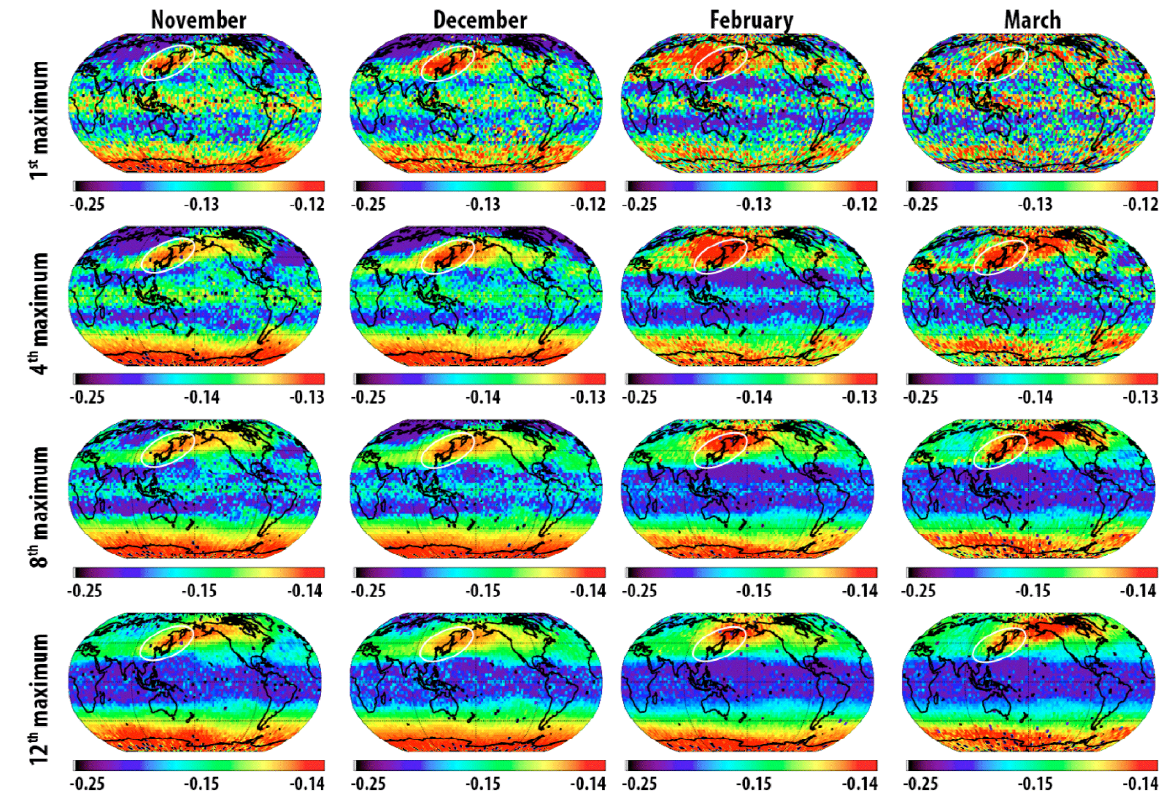
Figure 7. Selected monthly means of primary and selected secondary (i.e. higher order) sigma squared maxima in s − 2 for 2007–2010 (non-linear colour scale used).